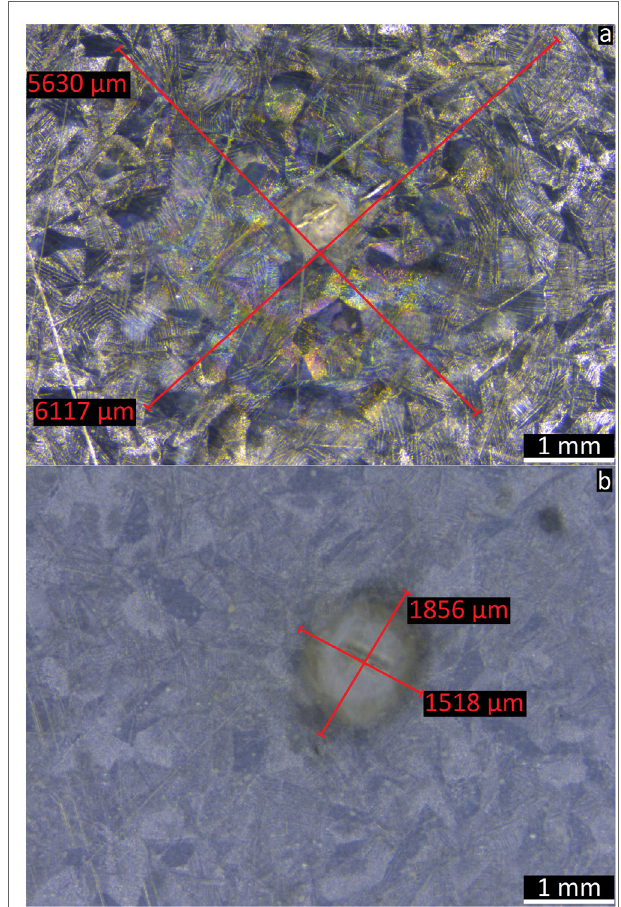
FigUre 7 | The optical microscope images show the corroded surface underneath the delaminated transparent coating with a defect in the center . The sample without corrosion inhibitor containers (a) shows 13 times bigger delamination than the sample where MBT was released from LDH in the coating (B)